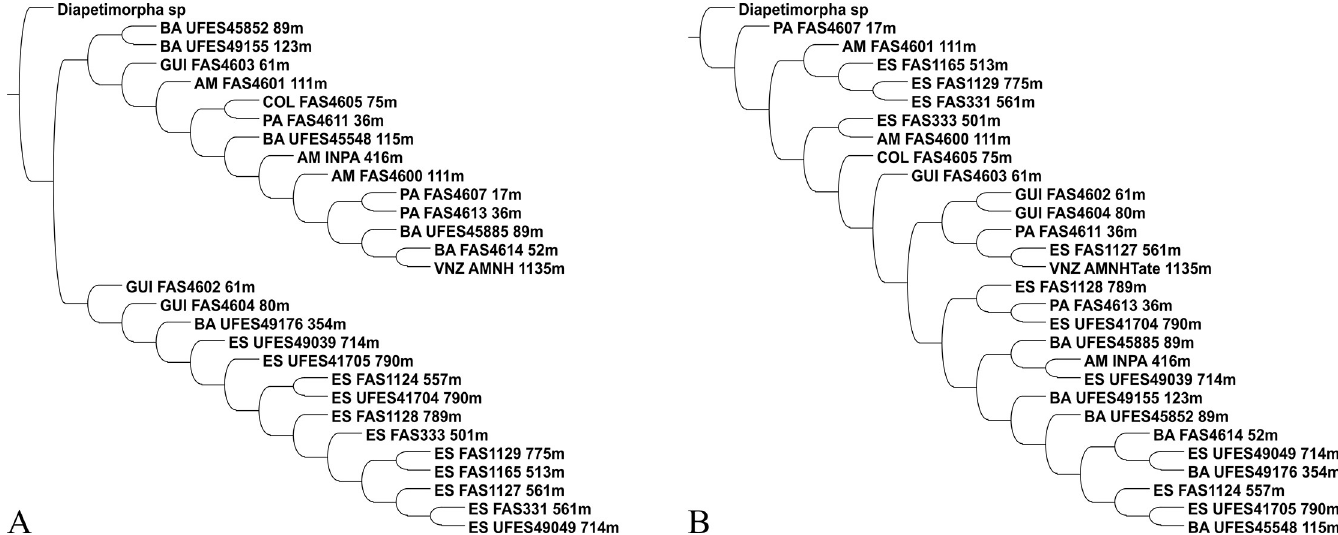
Fig 4. Most parsimonious interpretations for the observed morphological variation of C . metamorphus sp. nov. (females). (A) Using discrete characters only (Tables 3 and 4). K = 4.765625, Fit = 8.31342, Rearrangements tried: 1,052,652,173. Length = 164, CI = 26, RI = 57. (B) Combining discrete characters with RGB as quantitative characters. K = 20.048829, Fit = 27.68569, Rearrangements Tried: 996,214,326. If this topology is used with the discrete character matrix, Length = 275, CI = 16, RI = 17. GUI corresponds to French Guiana, COL to Colombia, and VNZ to Venezuela; two-letter tags correspond to Brazilian states. Both analyses recovered a single tree found with implied weights, with the constant of concavity (K) defined by the algorithm setk.run.